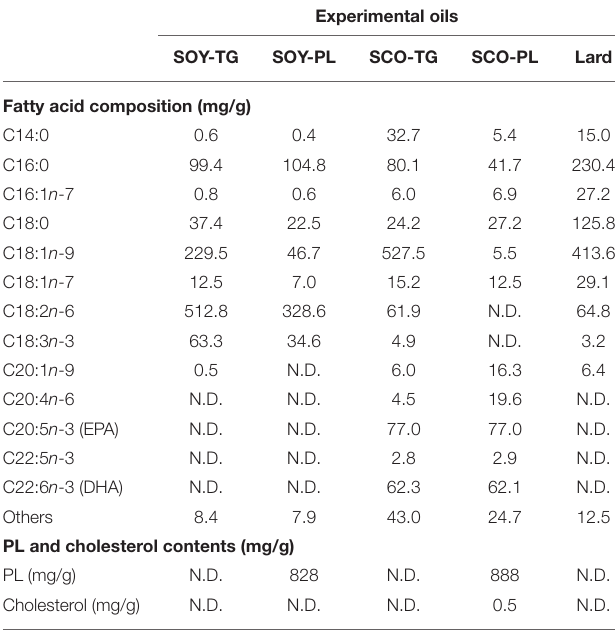
TABLE 1 | Lipid profile of the experimental oils.